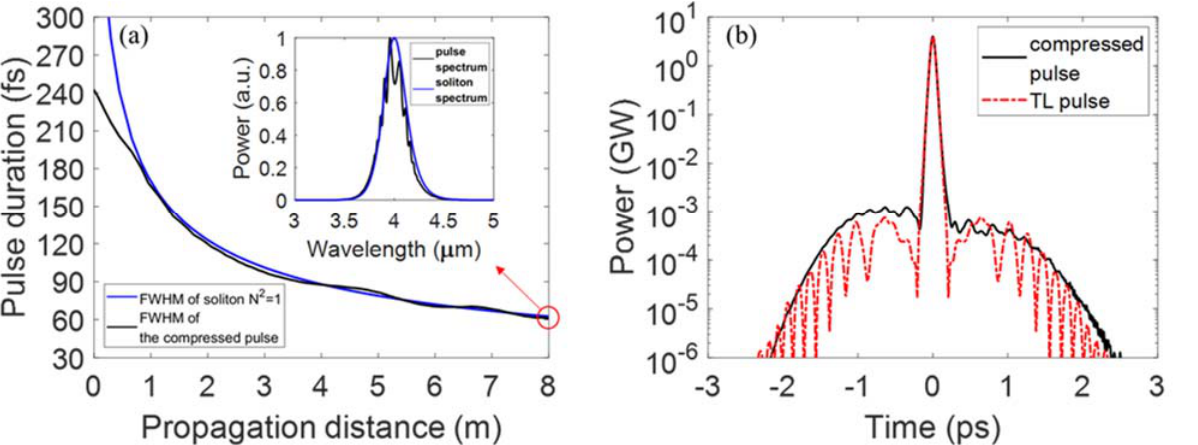
Figure 6. ASC of a positively pre-chirped 280 µ J pulse at 4 µ m. ( a ) FWHM of a fundamental soliton (blue curve) and FWHM of ac ompressed pulse (black curve) versus the propagation distance. Inset: pulse spectrum (black curve) and soliton spectrum (blue curve) at the output of the second HCF. ( b ) Compressed pulse (black curve) and transform-limited (TL) pulse (red dashed curve) at HCF output.